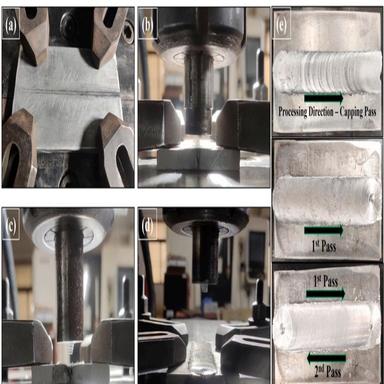
FSP process stages (a) TiAl reinforcement filled double grooved plate (b) Capping of groove with pin less tool (c) Taper threaded pin FSP pass (d) Square pin FSP pass (e) Developed AA6061/TiAl composite sample.